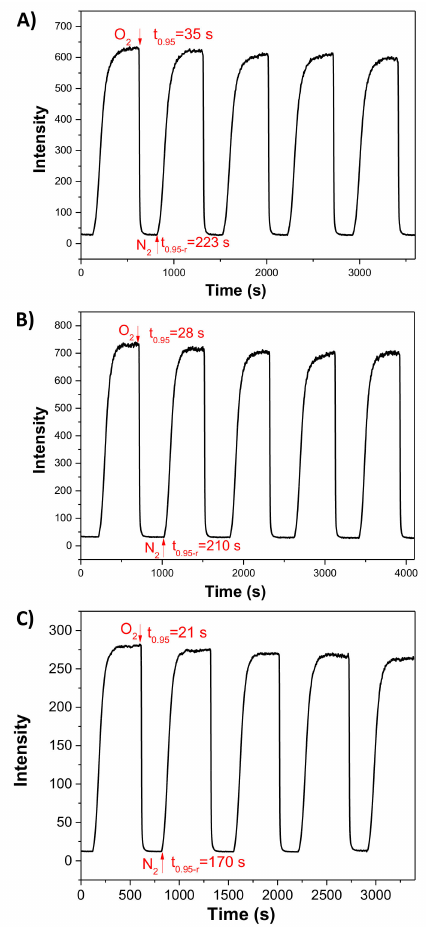
Figure 7. Reversibility and response time tests of the micelles M1 ( A ), M2 ( B ), and M3 ( C ) with